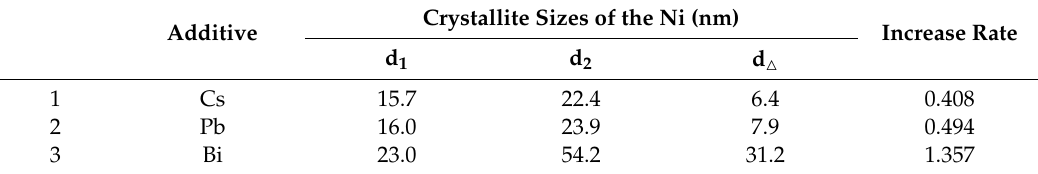
Table 6. Experimental result of anti-sintering for verifing.